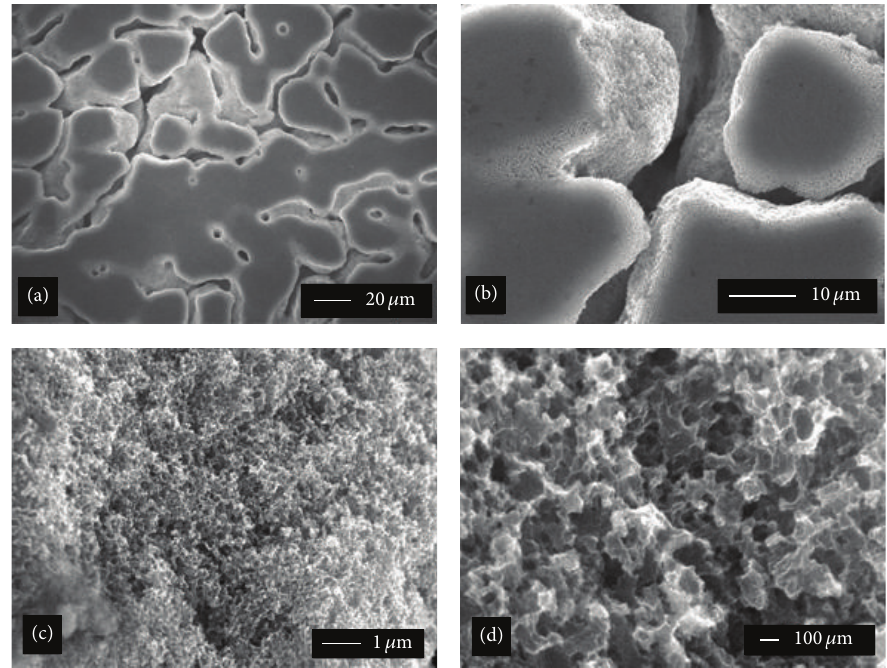
Figure7:Al-25at.%ZnalloyquenchedintoliquidnitrogenandelectrochemicallycorrodedinHNO 3 .(a)Typicalmicrostructuremorphology after selective dissolution. (b) Roughness observed in walls suggests presence of secondary porosity. (c) Resulting morphology of dendrite walls. (d) Higher magnification of image. (c) An interconnected ligament network with nanosized pores can be